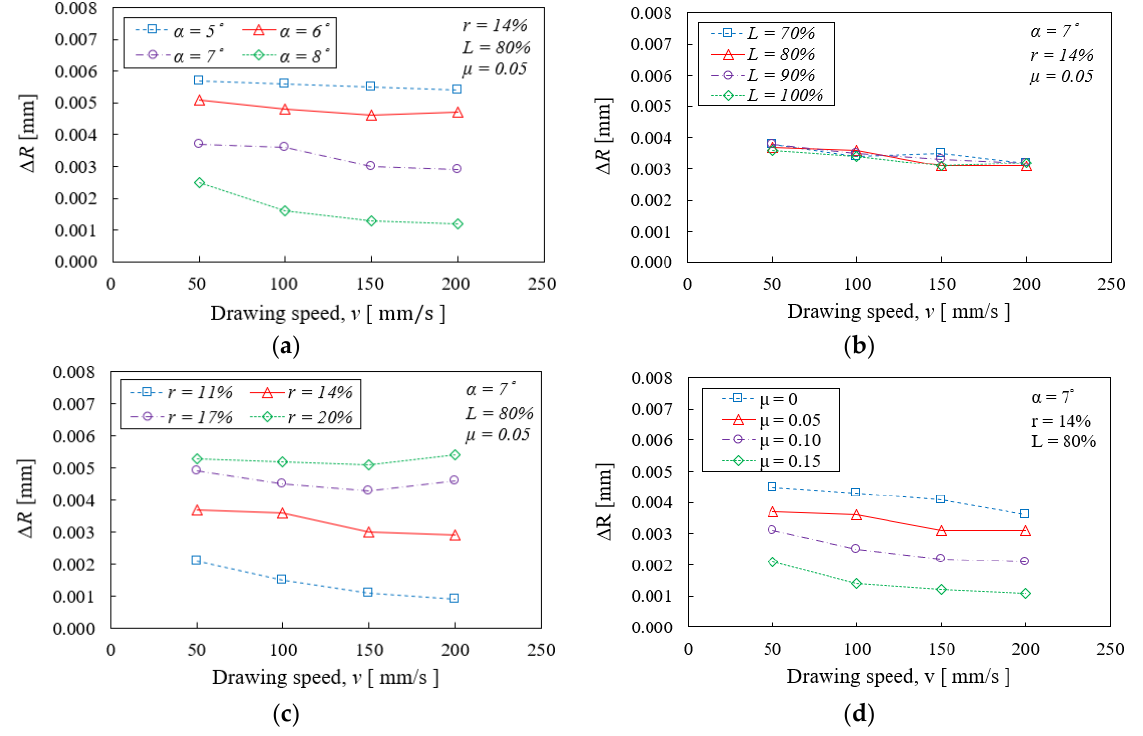
Figure 9. Effects of drawing speed on ∆ R under different conditions. ( a ) Different semi-die angles; ( b ) different bearing ratios; ( c ) different reduction ratios; ( d ) different friction coefficients.